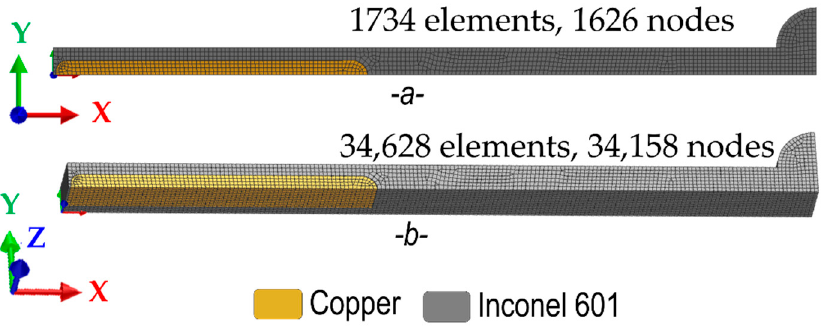
Figure 8. Finite element meshes for ( a ) generalized plane strain model and ( b ) three-dimensional (3D) model.